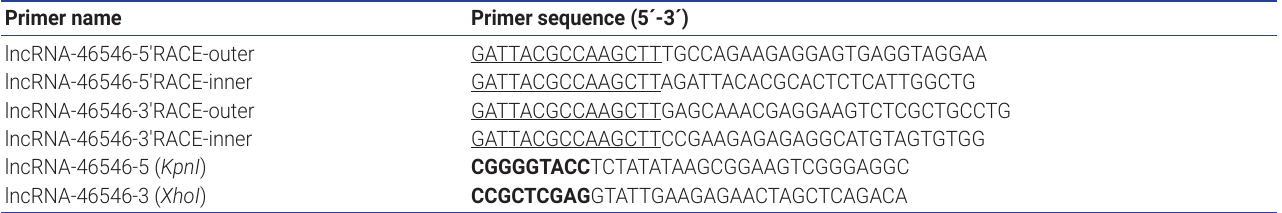
Table 1. Primers used for rapid amplification of cDNA ends polymerase chain reaction and vector construction